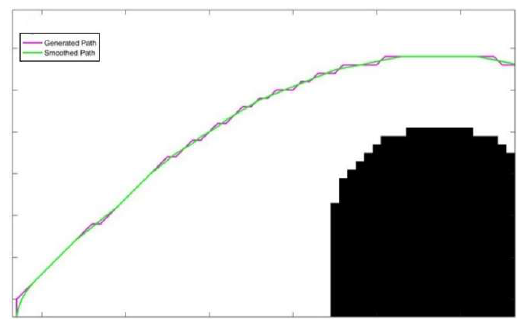
Figure 15. Representation of the generated and smoothed paths.